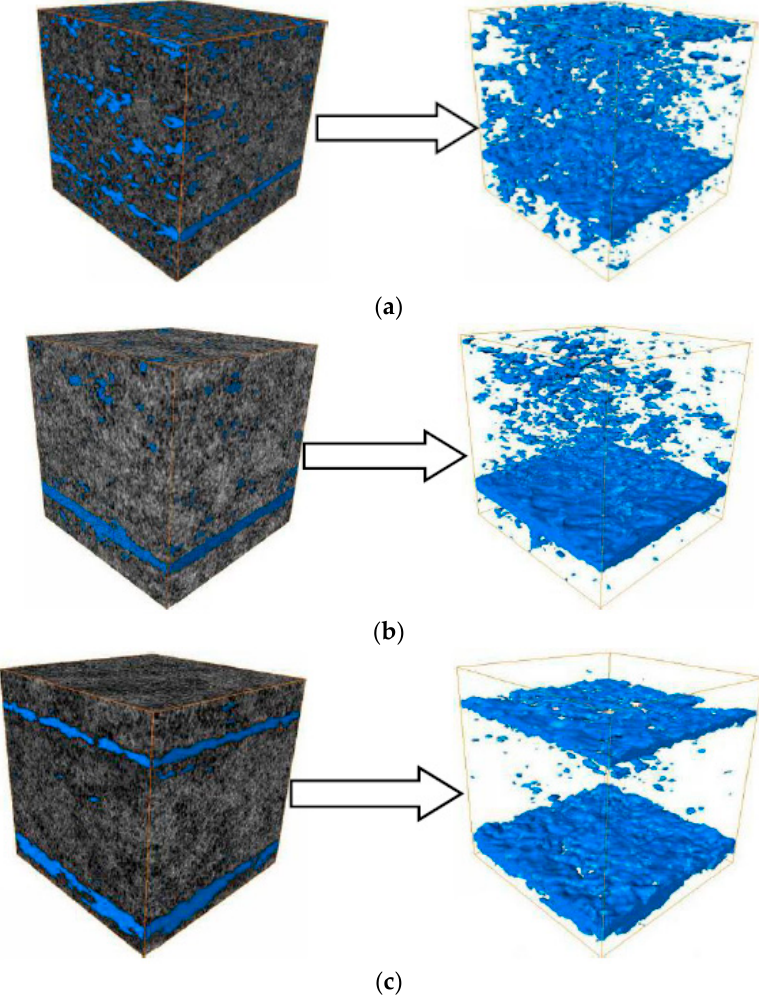
Figure 15. Distribution characteristics of internal holes and fractures in oil shale: ( a ) pore and fracture groups of oil shale at location A; ( b ). pore and fracture groups of oil shale at location B; ( c ) pore and fracture groups of oil shale at location C.